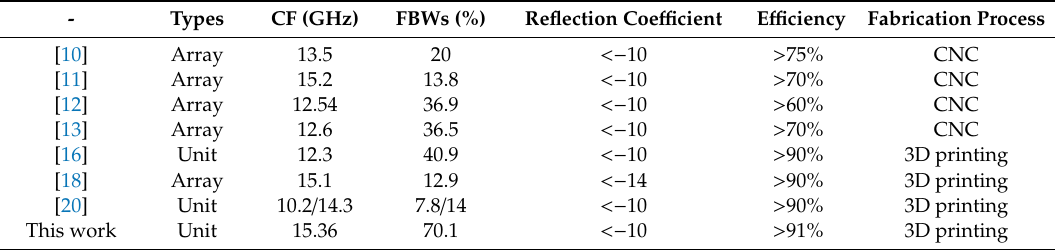
Table 1. Comparison with previous SWAs. CF, center frequency; FBW, fractional